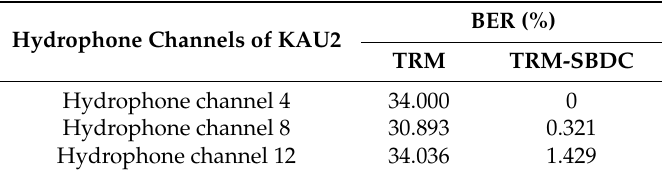
Table 2. The decoding results of different hydrophone channels.